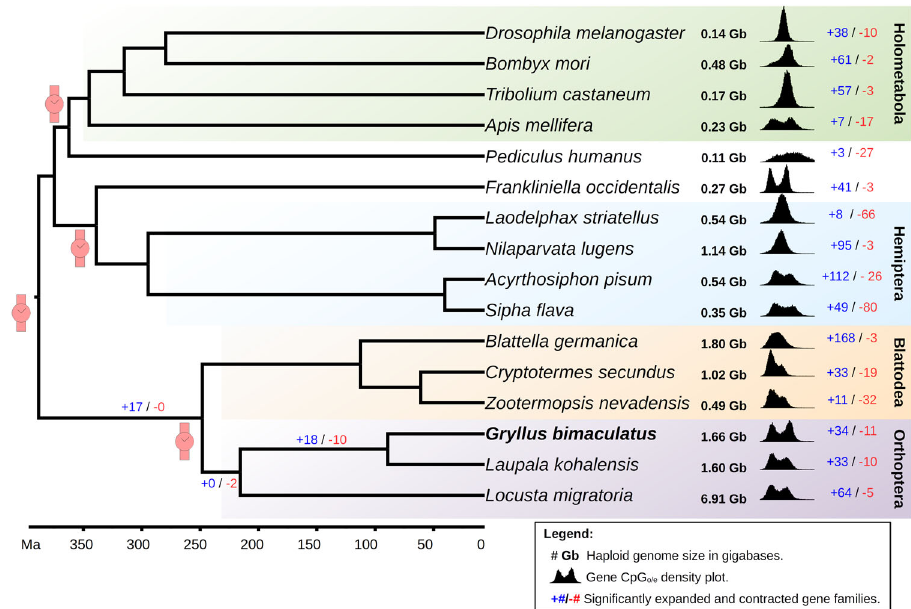
Fig. 4 Cricket genomes in the context of insect evolution. A phylogenetic tree including 16 insect species calibrated at four different time points (red watch symbols) based on Misof et al. (2014) 23 , suggests that G. bimaculatus and L. kohalensis diverged ca. 89.2 Mya. The number of expanded (blue text) and contracted (red text) gene families is shown for each insect, and for the branches leading to crickets. The density plots show the CpG o/e distribution for all genes for each species. The genome size in Gb was obtained from the genome fasta fi les (Supplementary Data